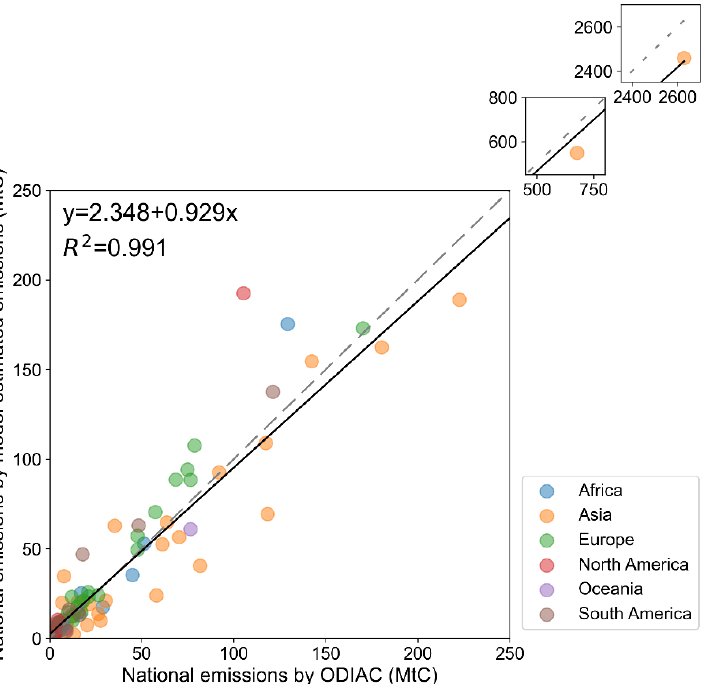
Figure 9. Scatterplots of national emissions. It shows the correlation between national emissions of 140 countries calculated by ODIAC and model estimates.